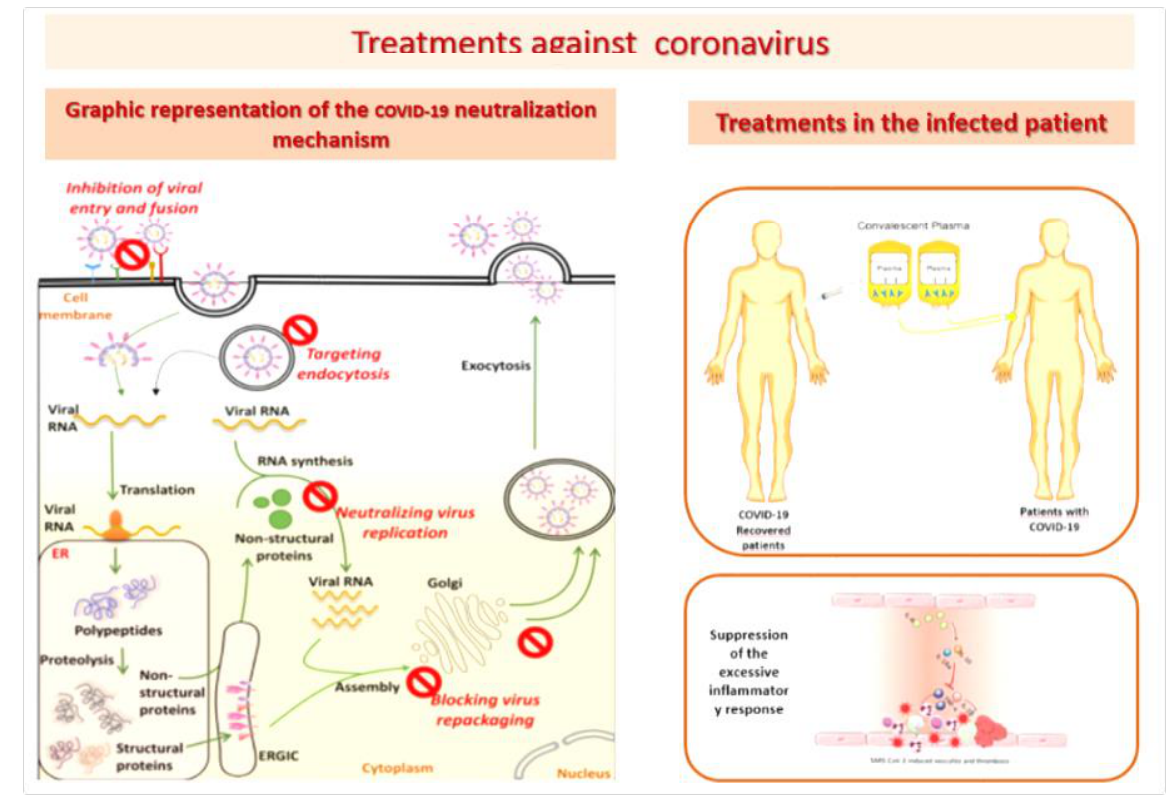
Figure 1. Treatment Against SARS-CoC-2.